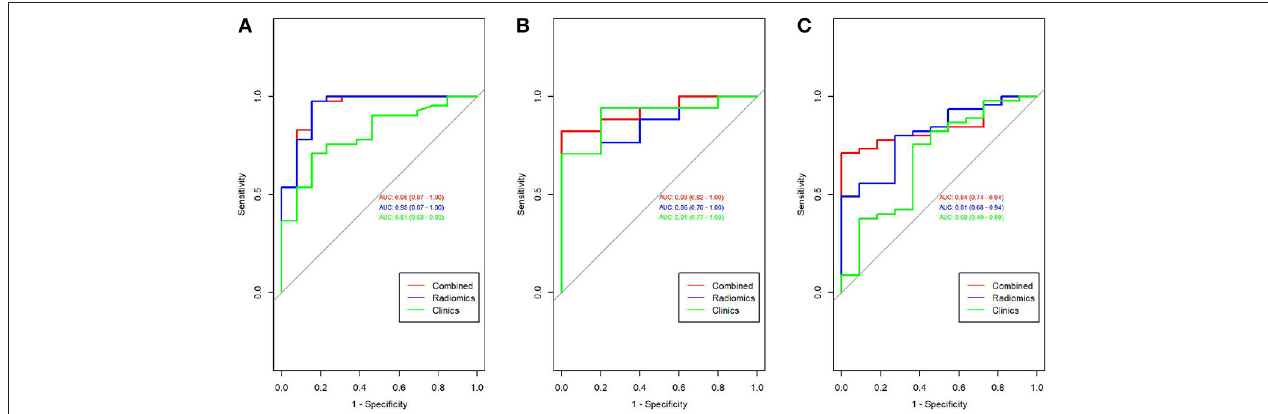
FIGURE 4 | The receiver operating curves (ROC) of a combination nomogram, radiomic signatures, and clinical risk factor for discriminating clinically significant and clinically insignificant prostate cancer were presented in the training group (A) , internal validation group (B) , and external validation group (C) . The combination nomogram obtained the highest area under the curve (AUC).